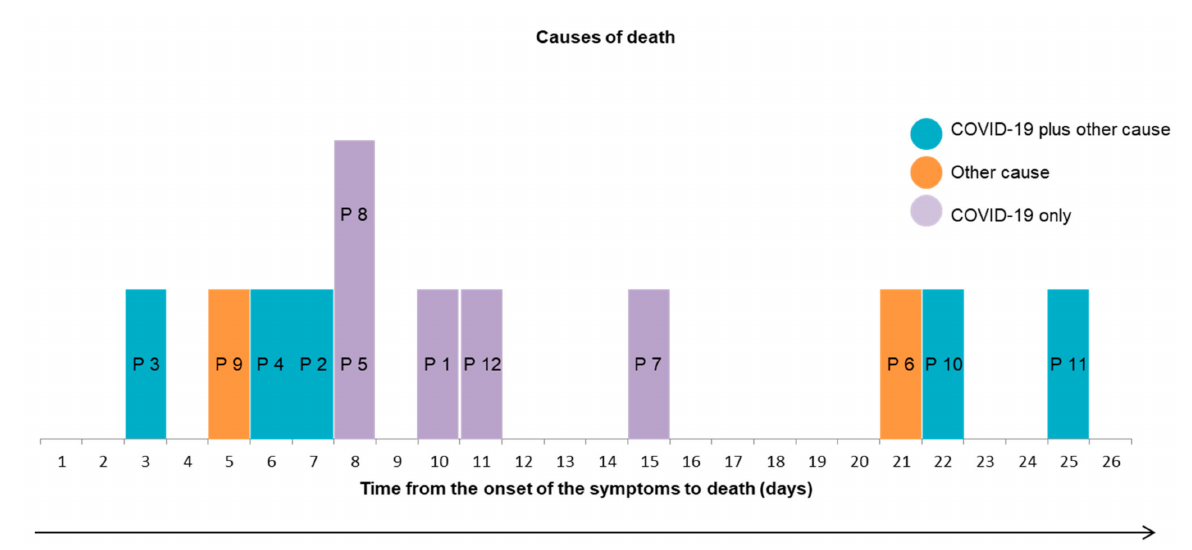
Figure 2. Causes of death according to time to death. Abbrevations: P: